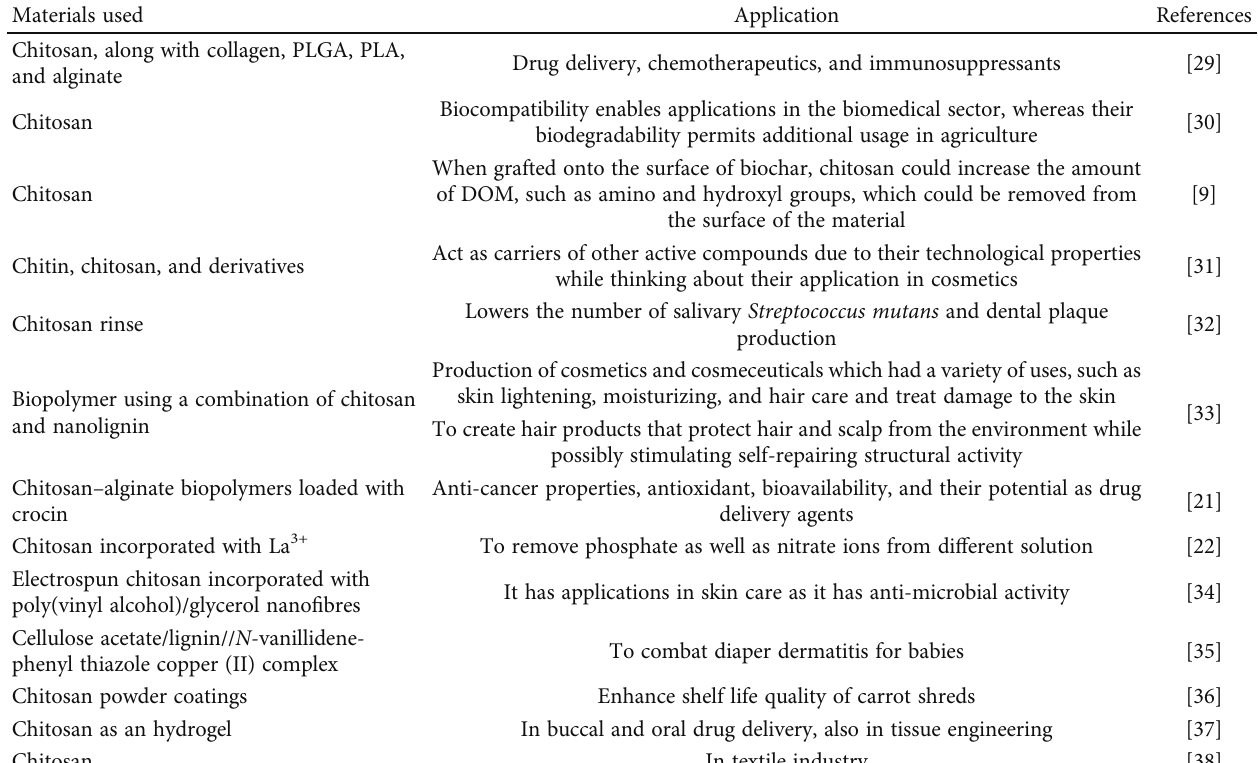
Table 1: Applications of